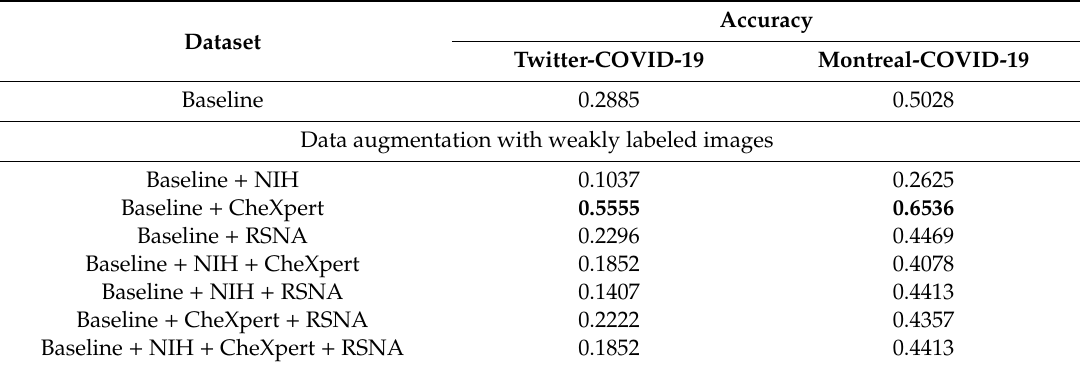
Table 9. Performance metrics achieved through weakly labeled data augmentation toward classifying the Twitter- and Montreal-COVID-19 CXR collections as belonging to the viral pneumonia category.